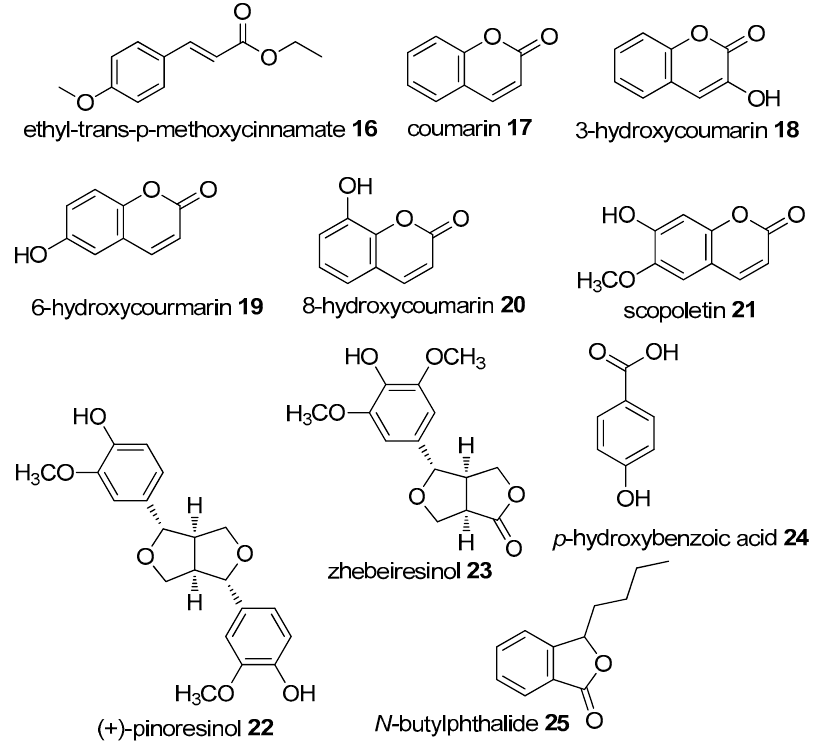
Figure 7. Compounds found in plants used by Tenggerese (isolated from same species found in other countries).